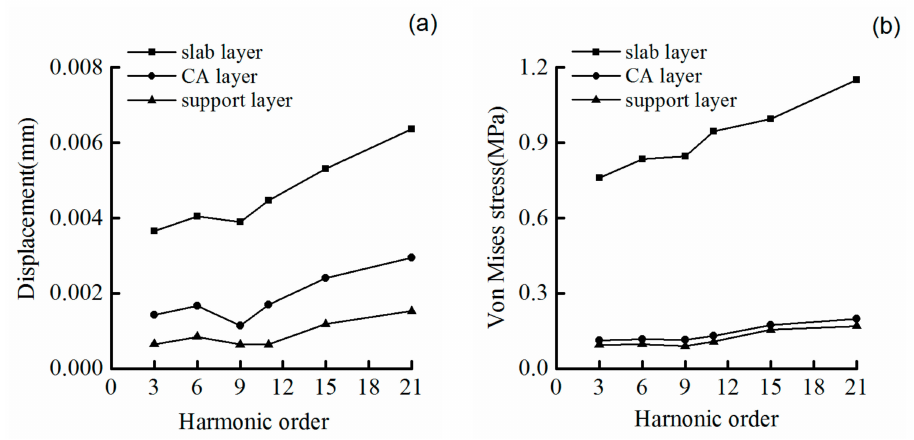
Figure 12. E ff ects of harmonic order on dynamics in rail-supporting structures: ( a ) displacement versus order and ( b ) von Mises equivalent stress versus order.